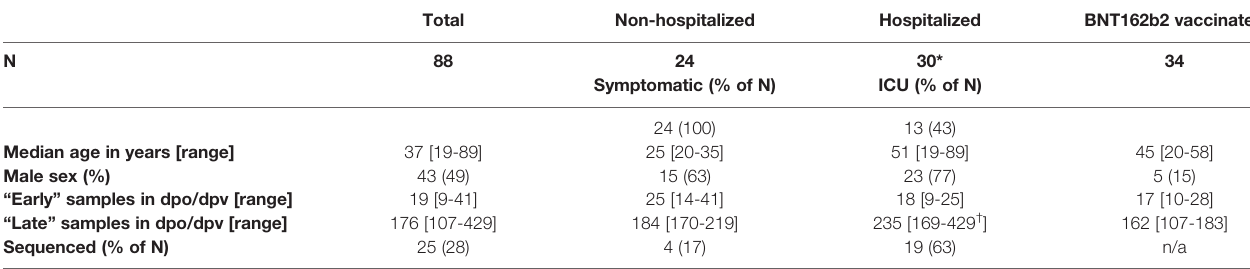
TABLE 1 | Description of study